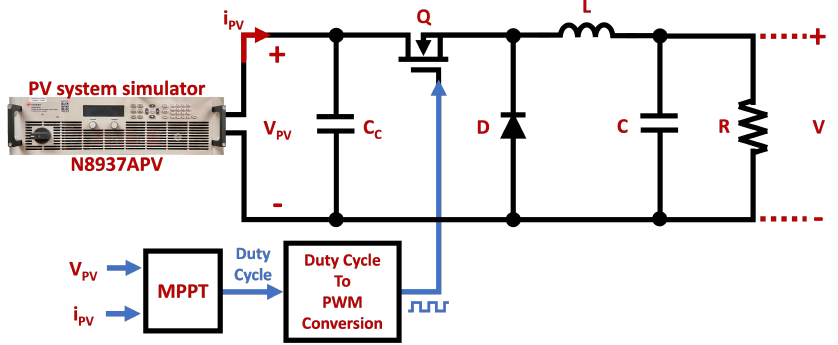
Figure 21. Topology with the N8937APV PV array simulator integrated for the case